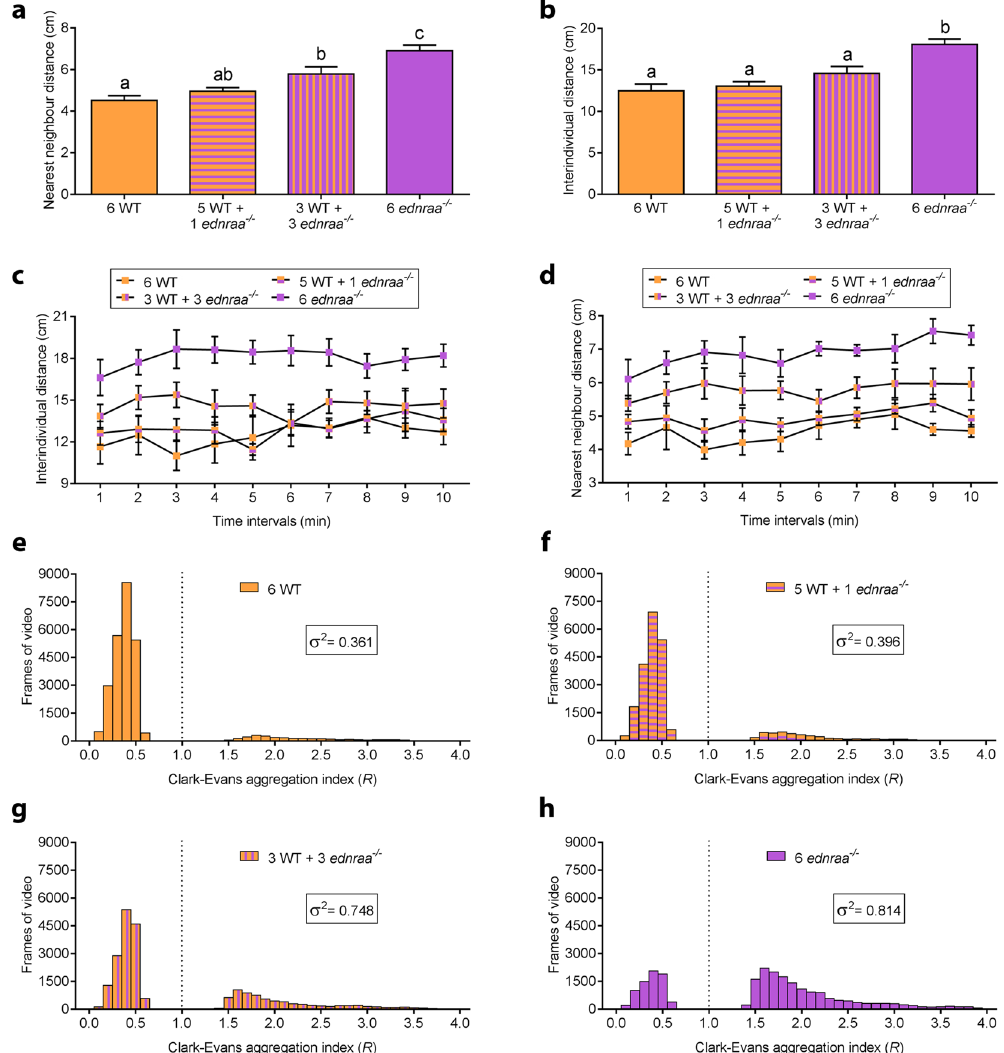
Figure 2. Social spacing in groups of mixed genotypes. ( a) Shoaling test. Mixed groups of ednraa − / − and WT (3:3) display an intermediate nearest neighbour distance and (b) inter-individual distance. (c) Average nearest neighbour and (d) inter-individual distance of the same fish as in a and b represented over time. (e – h) Shoaling test. Histograms showing the increase in the Clark-Evans aggregation index R as the number of ednraa − / − in the group of 6 fish increases. The variance of the data (inset) also increases with the number of mutants present in the group. Only frames in which aggregation or repulsion were significant (p < 0.05) are shown